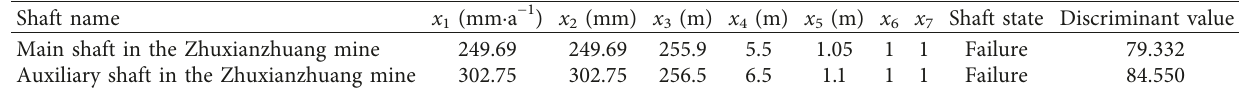
Table 7: Prediction of shaft stability with drastic drawdown